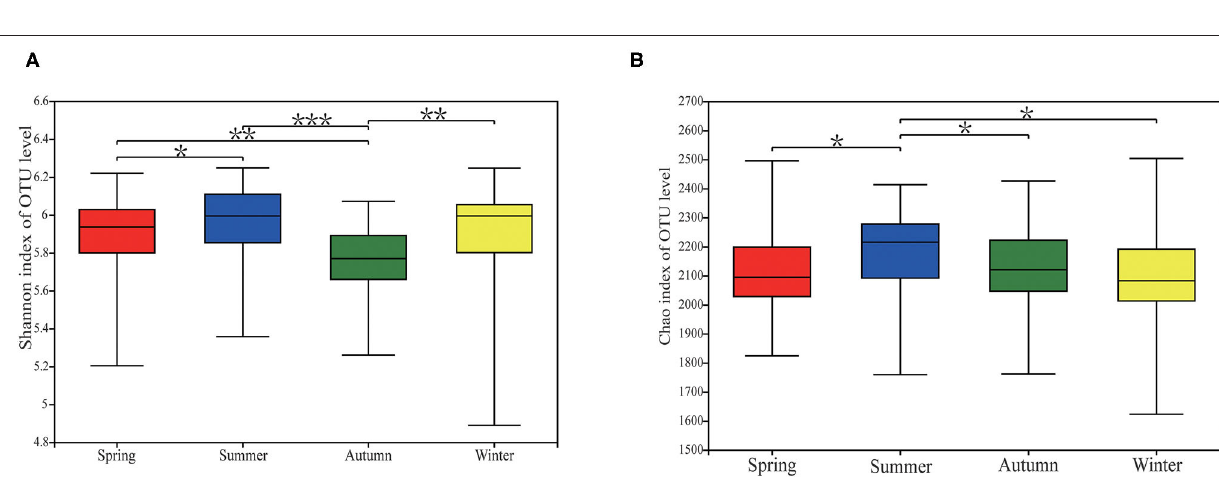
FIGURE 2 | Alpha diversity of gut microbial community in Chinese merino fine-wool Sheep. (A) Shannon index. (B) Chao index. After the Kruskal-Wallis rank sum test, the differences in alpha differentiation between groups were statistically significant, as indicated by different letters ( P ≤ 0.05). “*” means P ≤ 0.05, “**” means 0.001 < P ≤ 0.01, *** means P ≤